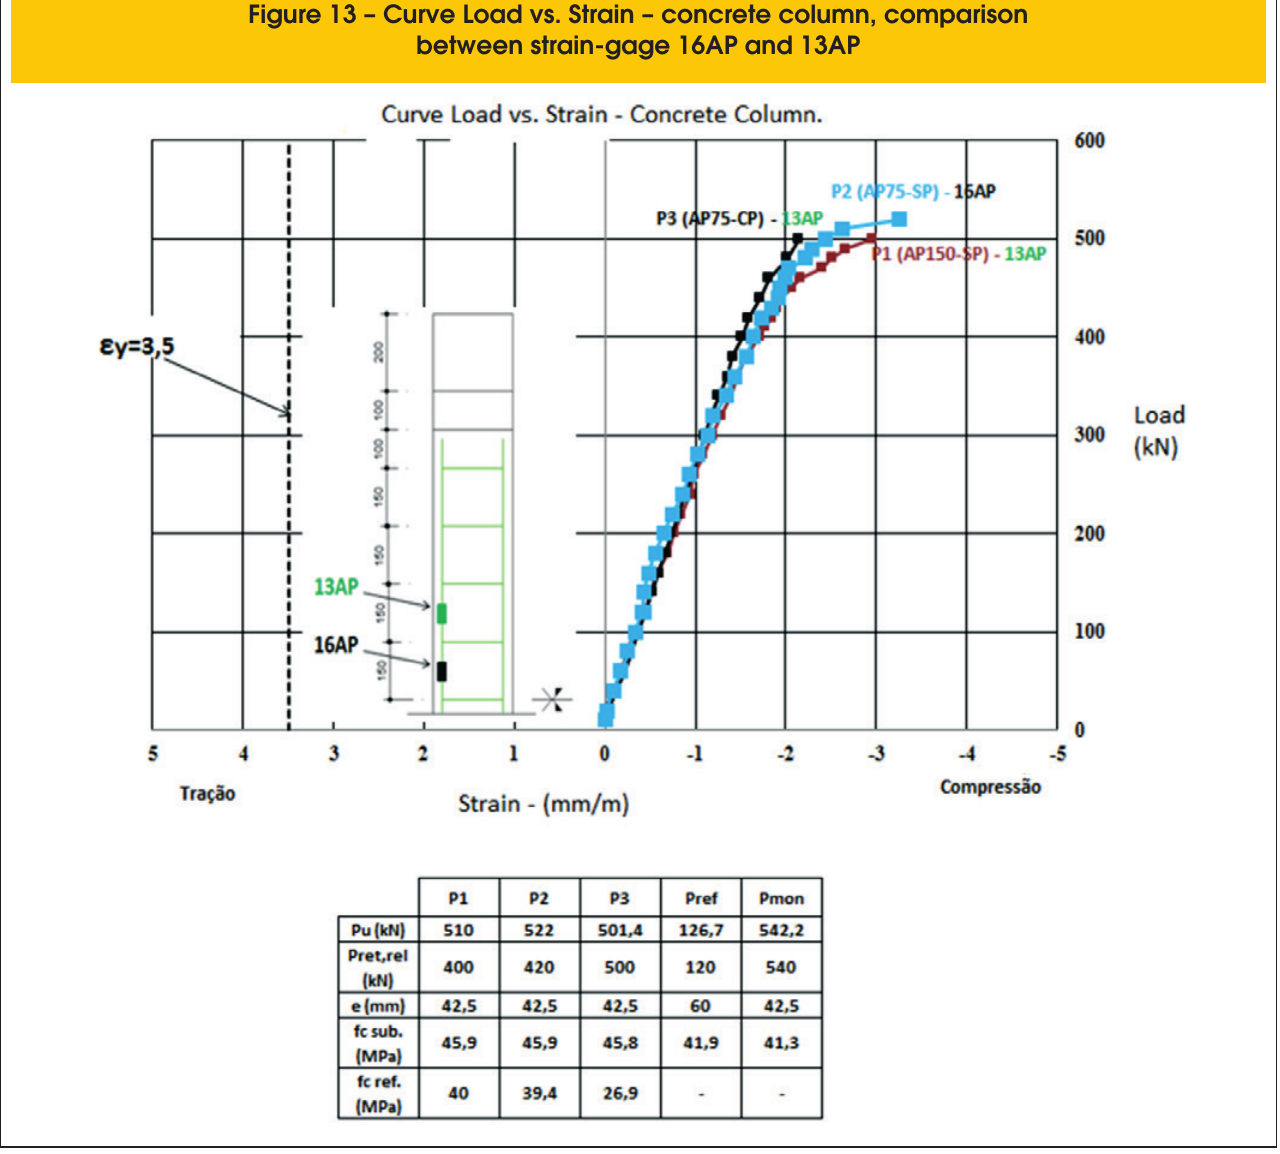
Figure 13 – Curve Load vs. Strain – concrete column, comparison between strain-gage 16AP and